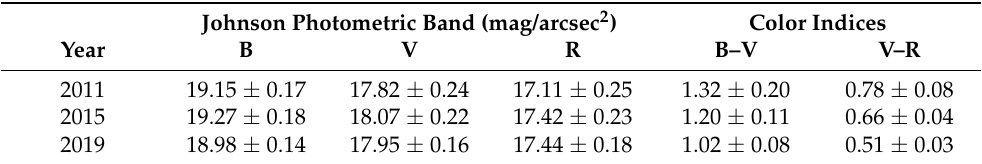
Table 6. Yearly median night sky brightness after